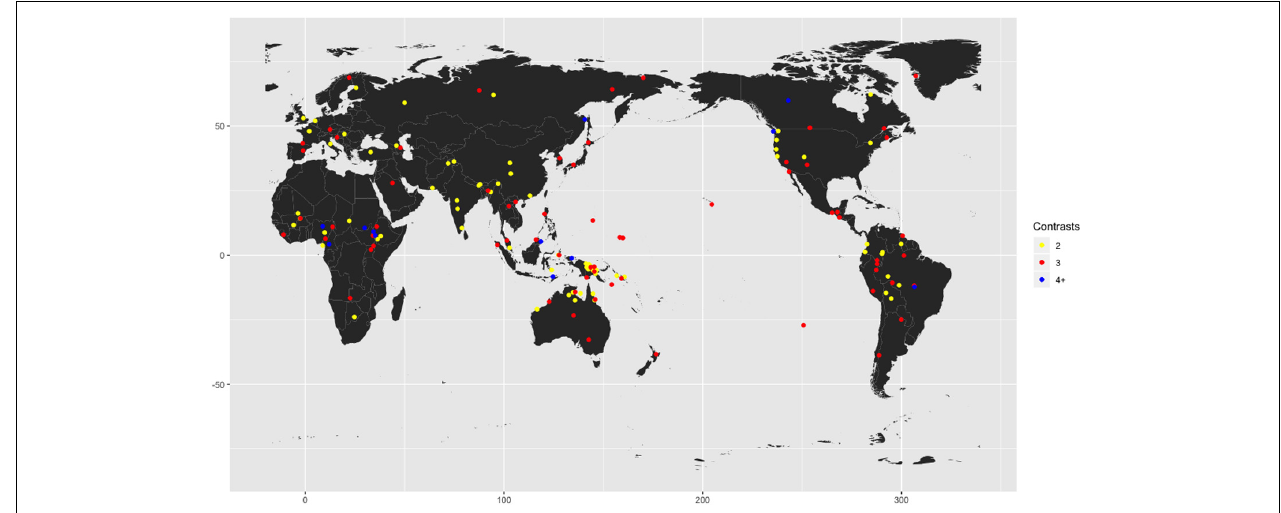
FIGURE 1 | Number of distance contrasts in spatial demonstrative adverbs in a 150 language